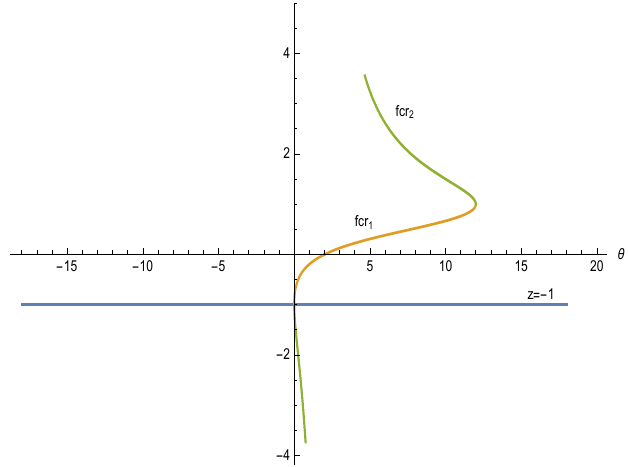
Figure 5. Behavior of free critical